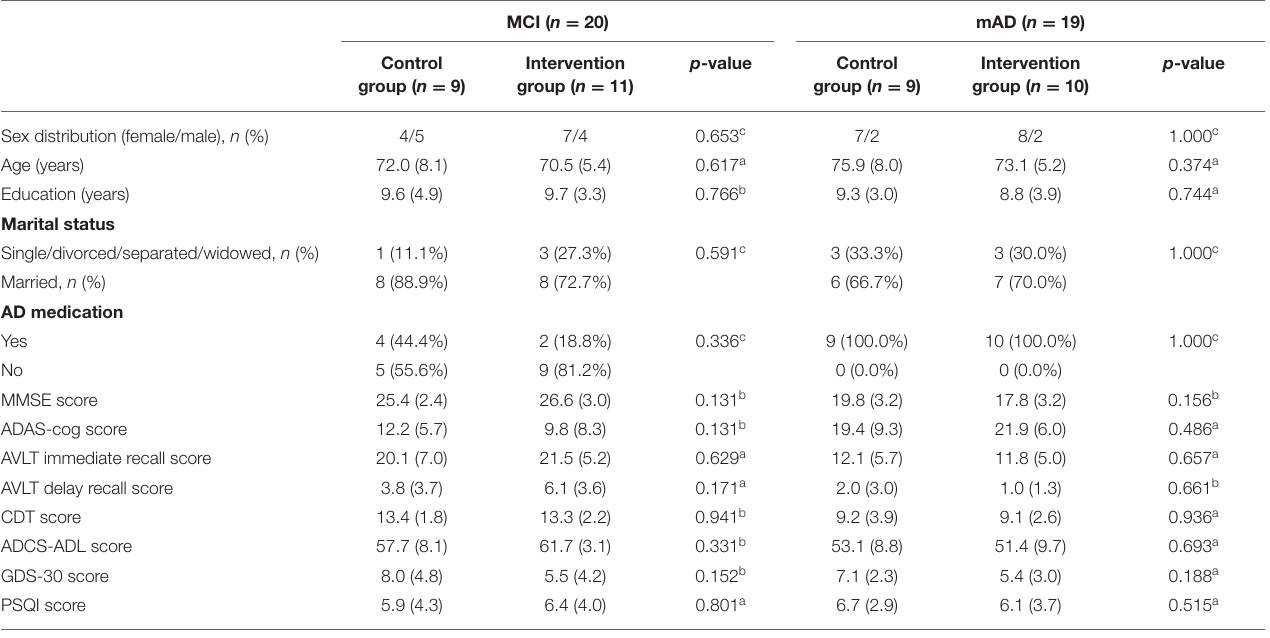
TABLE 1 | Baseline characteristics of the participants ( n =